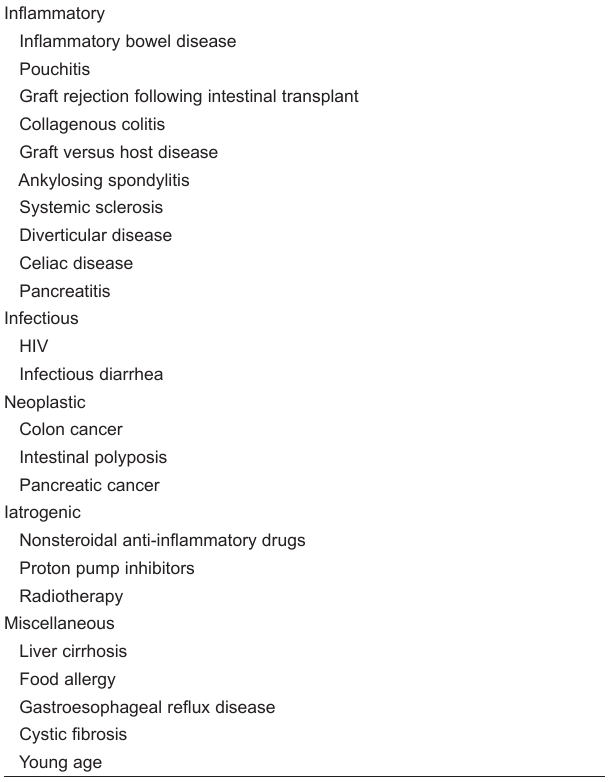
TABLE 1 Conditions associated with fecal calprotectin elevation